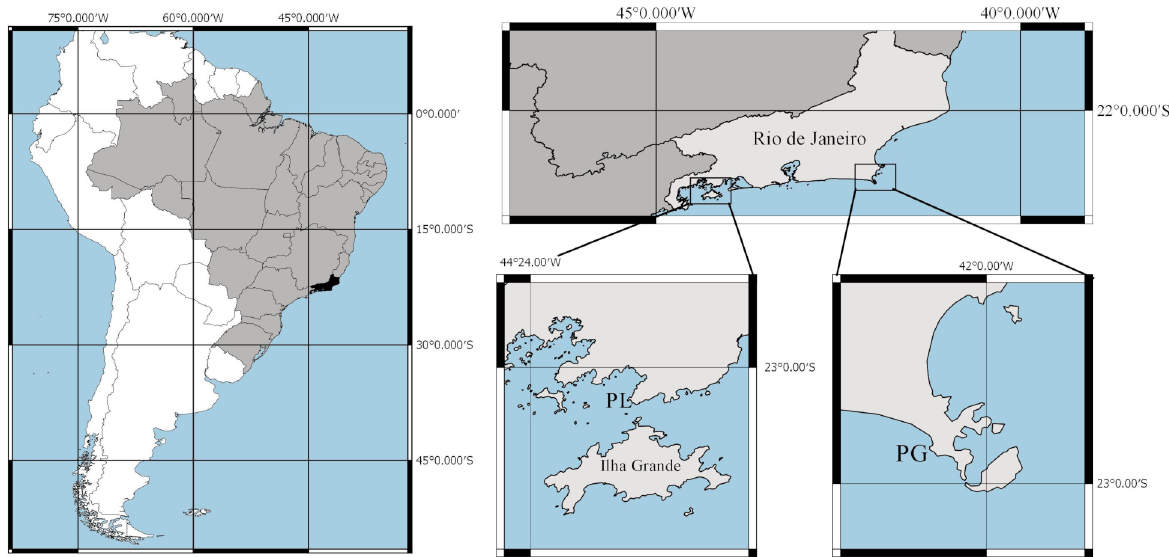
Figure 1. Map of the studied areas on the coast of Rio de Janeiro State. (PG = Praia Grande, in Arraial do Cabo); PL = Ponta Leste, in Ilha Grande Bay). Map generated by QGis V.